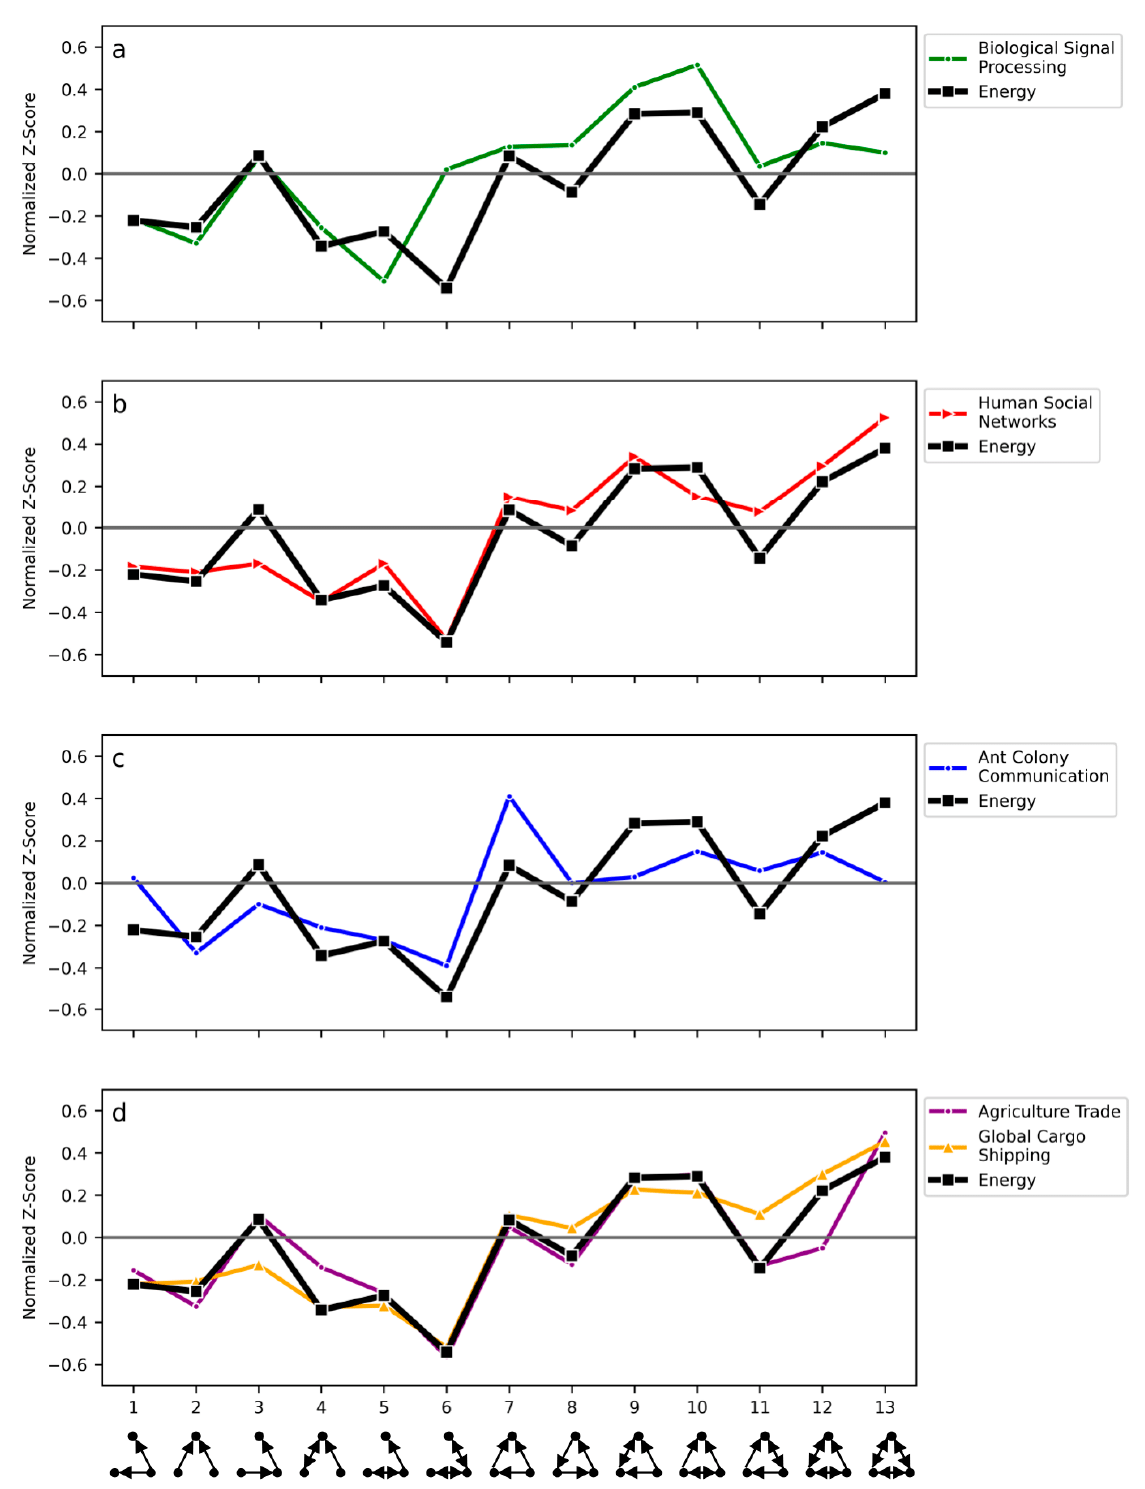
Figure 5. Comparison of the aggregate energy trade network TSP to other published TSPs, including ( a ) biological signal processing networks, ( b ) human social networks, ( c ) ant colony communication networks, ( d ) and two types of trade-related networks. Although energy trade shares several motifs and anti-motifs with both biological signal processing networks (R = 0.71) and human social networks (R = 0.91), it is most highly correlated with the network for global agricultural trade (R = 0.93). See Table 2 for a full set of correlation coefficients.